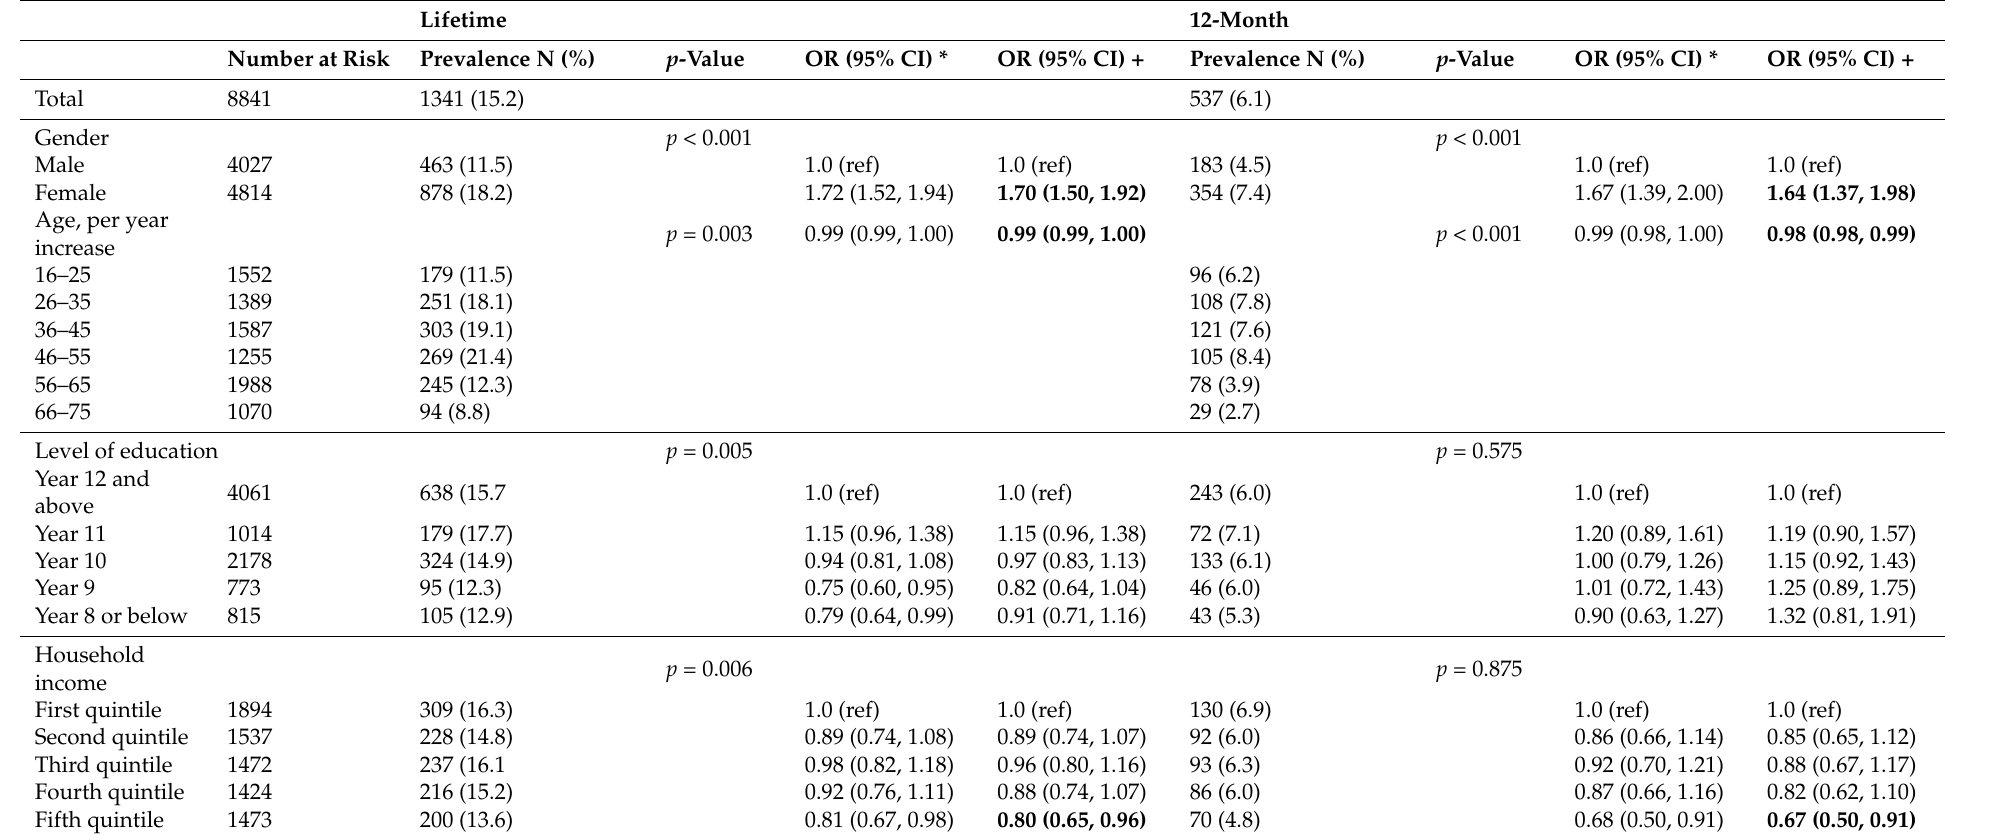
Table 2. Prevalence and Odds Ratio of lifetime and 12-month depression on selected sociodemographic factors in the 2007